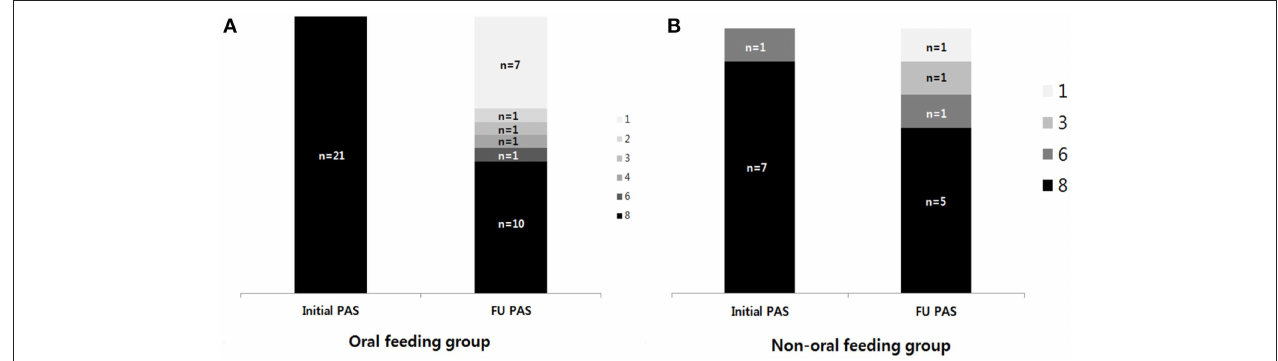
FIGURE 2 | The change in the penetration-aspiration scale (PAS) between the first VFSS and follow-up VFSS. (A) Oral feeding group; (B) non-oral feeding group. (1) Material does not enter the airway. (2) Material enters the airway, remains above the vocal folds, and is ejected from the airway. (3) Material enters the airway, remains above the vocal folds, and is not ejected from the airway. (4) Material enters the airway, contacts the vocal folds, and is ejected from the airway. (5) Material enters the airway, contacts the vocal folds, and is not ejected from the airway. (6) Material enters the airway, passes below the vocal folds, and is ejected into the larynx or out of the airway. (7) Material enters the airway, passes below the vocal folds, and is not ejected from the trachea despite effort. (8) Material enters the airway, passes below the vocal folds, and no effort is made to